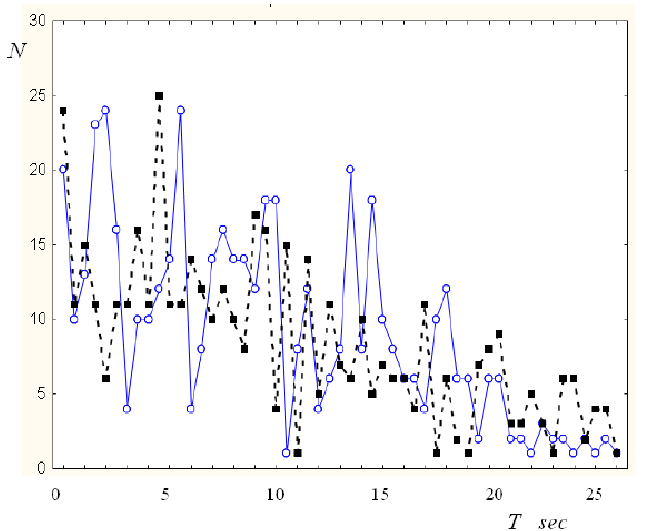
Figure 5. Fits of T distributions for fish eggs radiation; broken line: 8 ÷ 11 stages; solid line 12 ÷ 16 stages